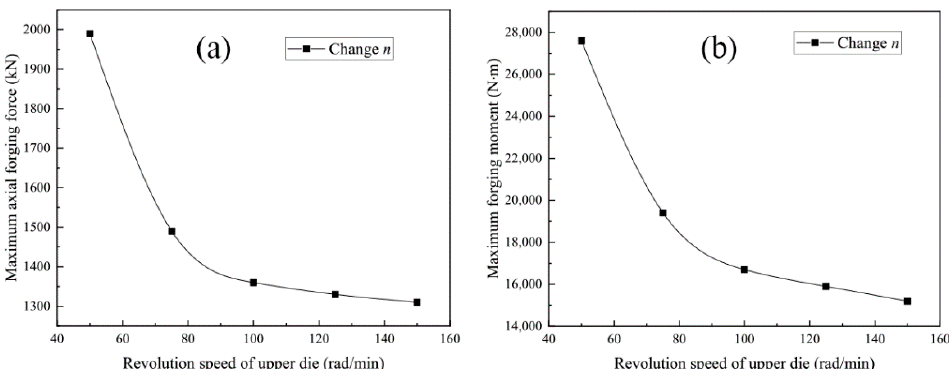
Figure 11. Influence of rotational speed n of the upper die on the maximum axial forging force and forging moment: ( a ) influence of rotational speed n of the upper die on the maximum axial forging force; ( b ) influence of rotational speed n of the upper die on the maximum forging moment.